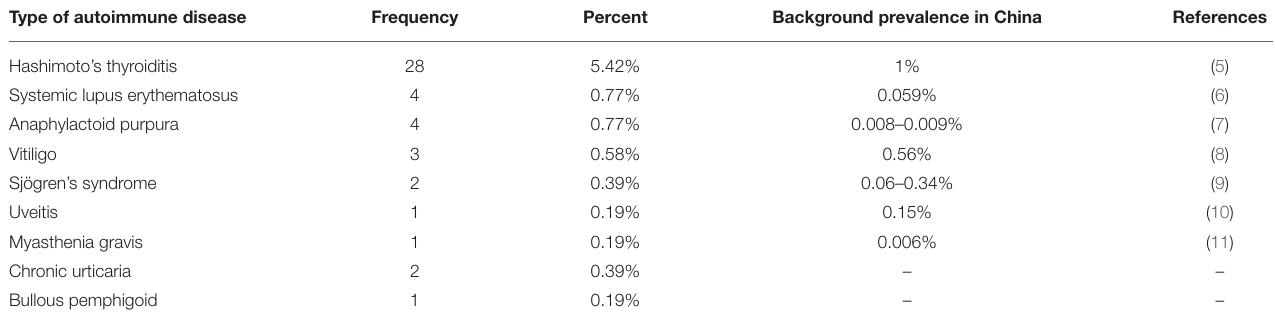
TABLE 2 | Types and percentages of concomitant autoimmune